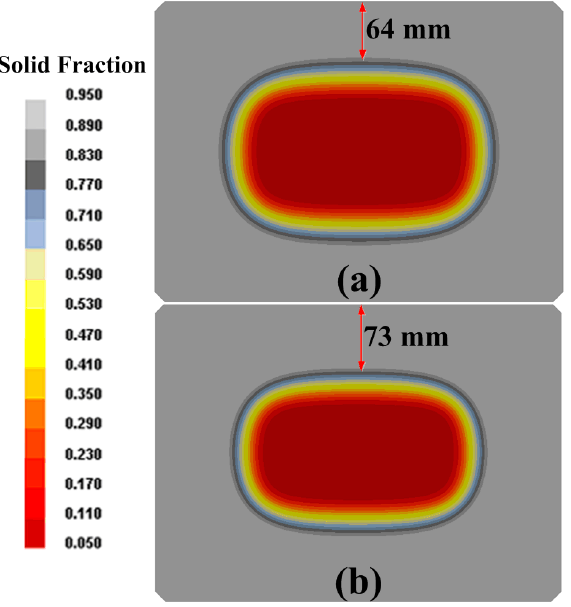
Figure 8. Contours of solid fraction at end of secondary cooling zone under SSC ( a ) and SC ( b ).